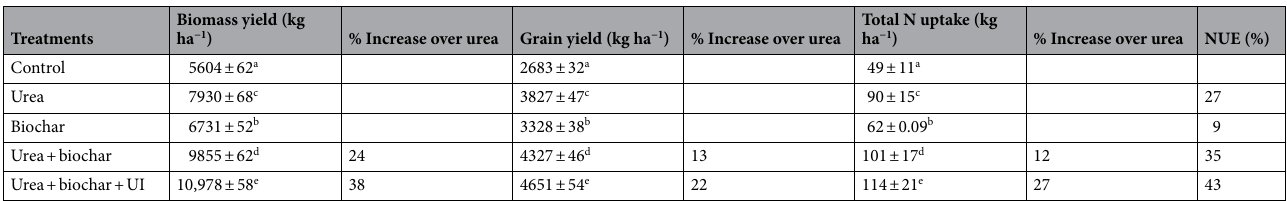
Table 3. Wheat biomass and grain yields (kg ha −1 ), N uptake (kg ha −1 ) and NUE (%) as affected by urea fertilization with and without biochar and/or urease inhibitor. Means followed by same letter(s) within columns are statistically non-significant (p <